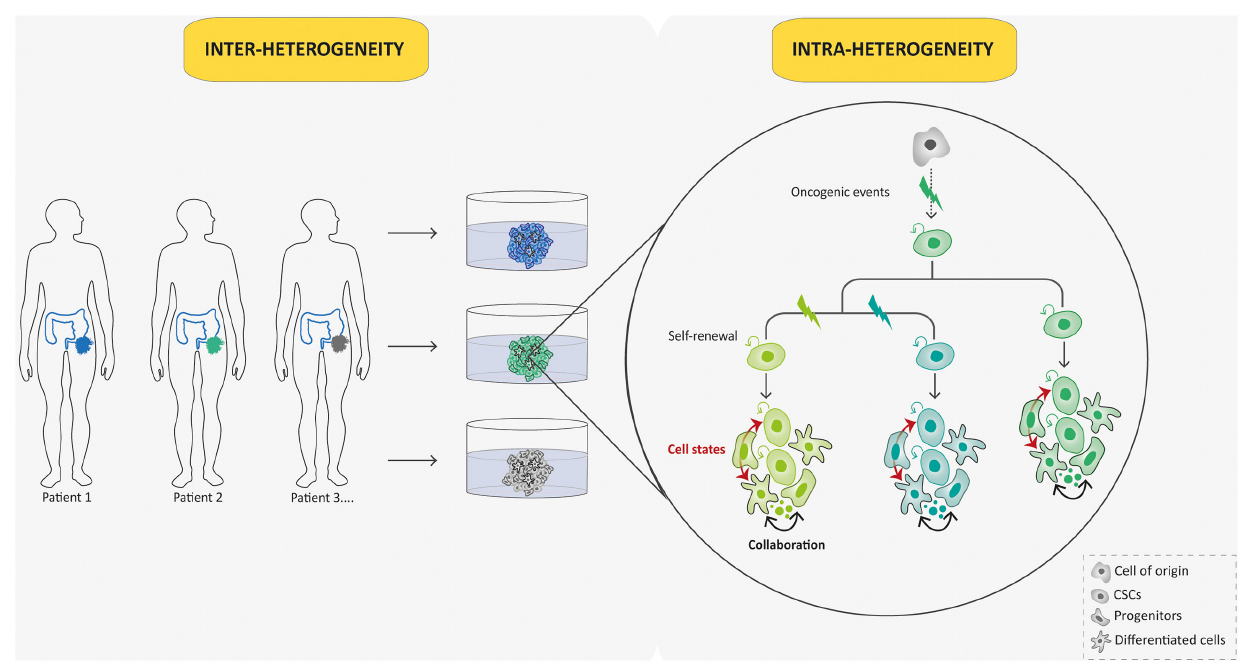
FIGURE 4 | Tumoroid reconstruct inter- and intra-tumoral hierarchy and dynamics. Tumoroids can be used to evaluate the importance of tumor heterogeneity: inter-tumoral heterogeneity in which tumors of the same type but from different patients have distinct clinical features, and intra-tumoral heterogeneity in which different populations within a tumor have divergent genotypes and phenotypes. Indeed, in this case, different subclones (represented by different colors) emerge due to multiple oncogenic events from a common ancestor (cell-of-origin). Cancer stem cells (CSCs) that arise from these events can self-renew and produce various cell lineages present in a tumor (different cell states from each subclone are represented in respective colors). This intra-tumoral heterogeneity can be affected by the tumor microenvironment and collaboration between tumor